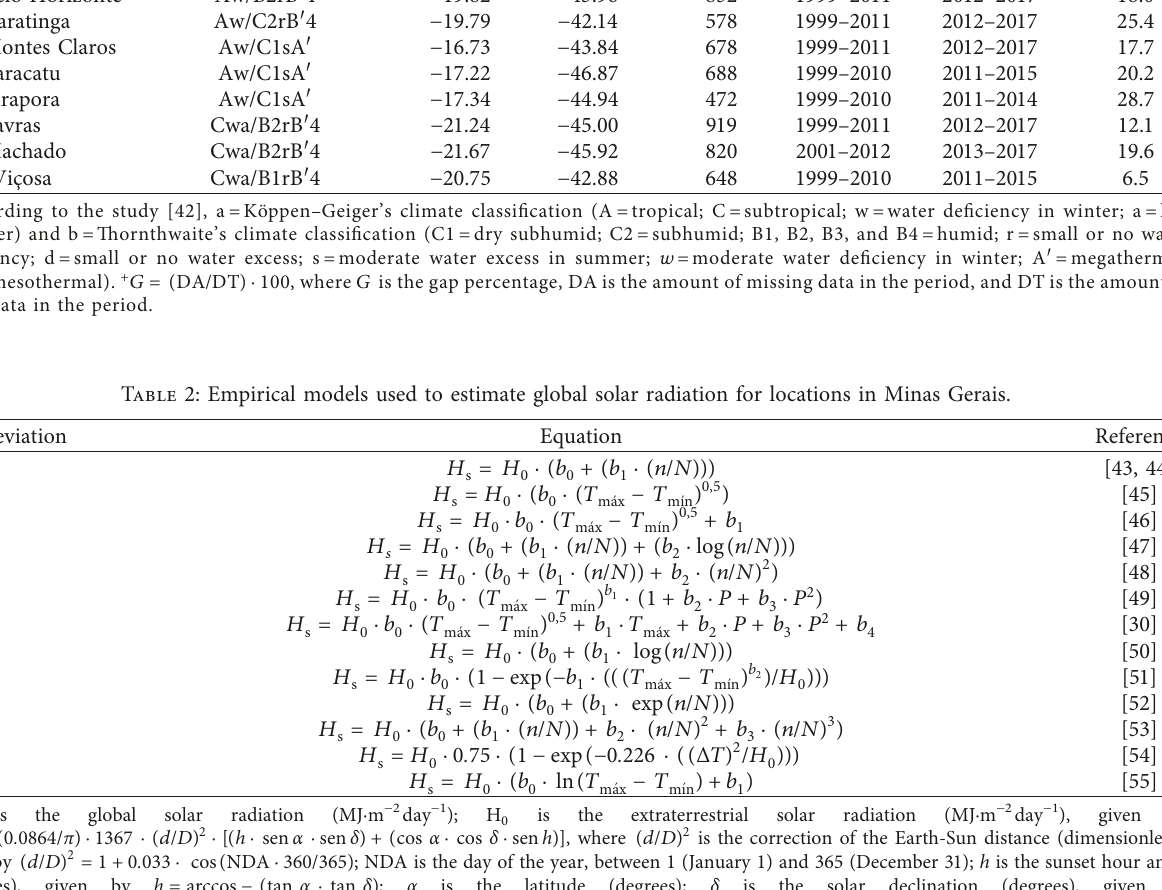
Table 1: Location and periods used in the goodness-of-fit and validation tests and the omission percentage of the data used in the empirical models to estimate global solar radiation in Minas Gerais.